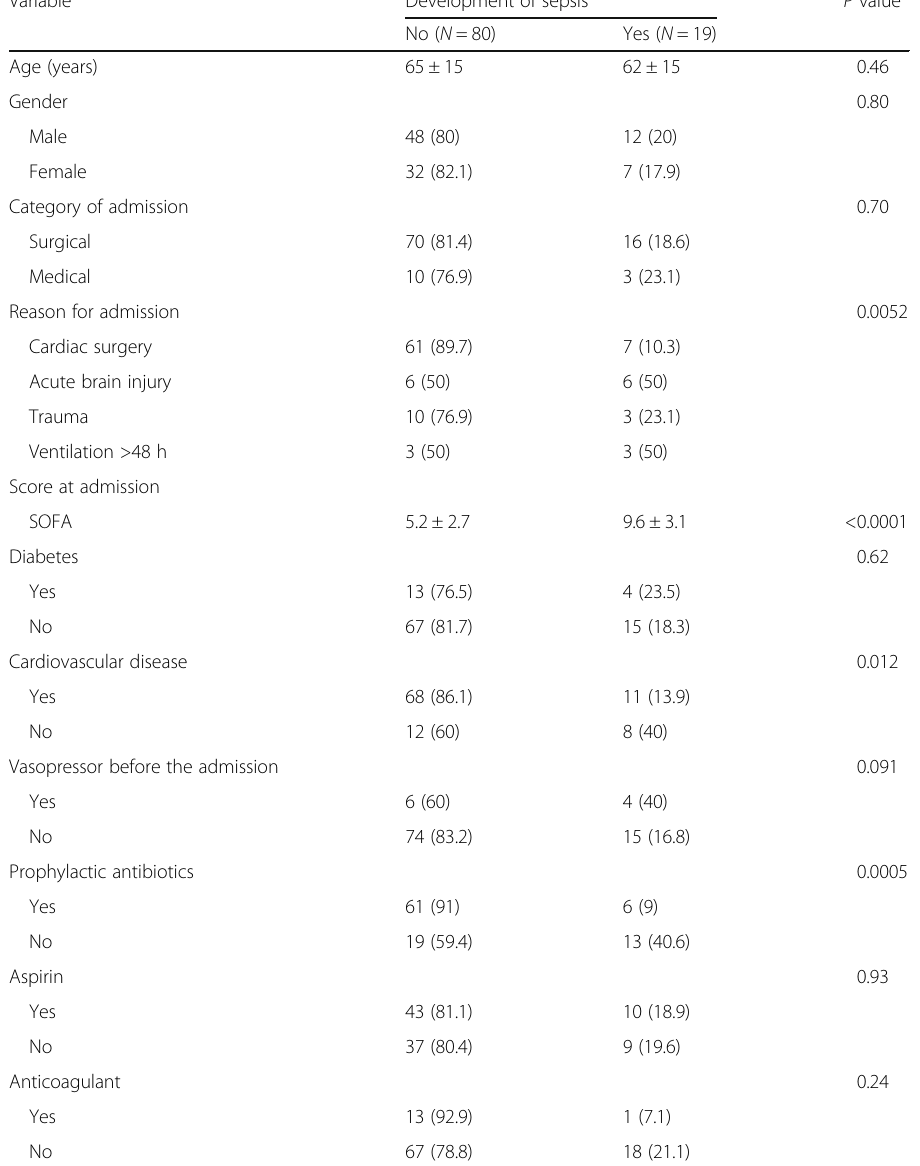
Table 1 Predictive value of patient demographic and baseline clinical data for sepsis development during ICU stay Variable Development of sepsis a P value